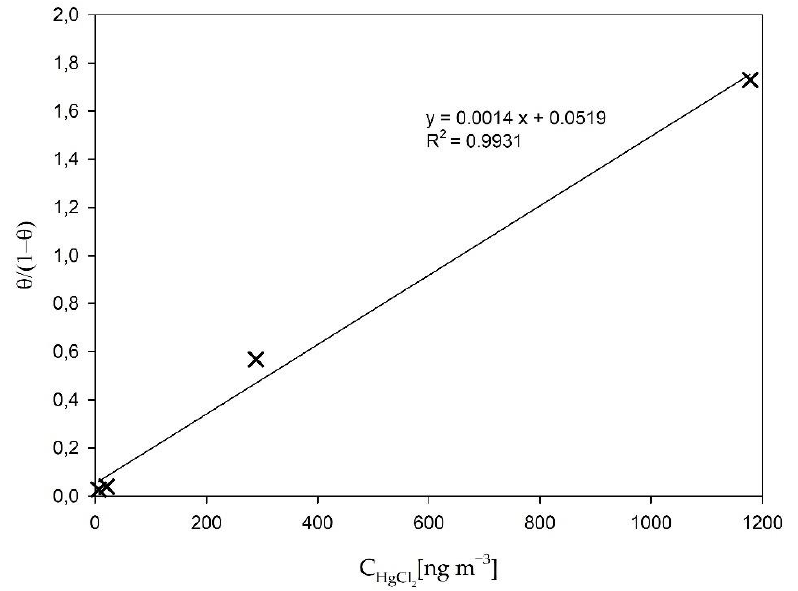
Figure 7. The Langmuir adsorption isotherm for HgCl 2 adsorption on Teflon tubing: 125 °C. θ presents the occupancy of adsorption sites, while C HgCl2 presents HgCl 2 gas concentration. From the slope ( k 125°C = 0.0014 m 3 ng −1 ) of the above presented Langmuir isotherm